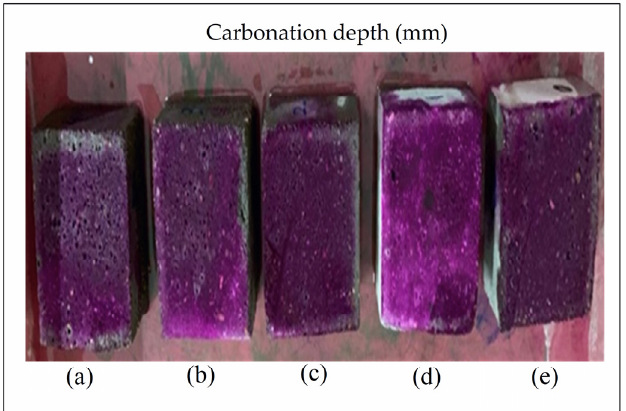
Figure 14. Carbonation depth of CM-UFS-GO composites. ( a )—CM1; ( b )—CM2; ( c )—CM3; ( d )—CM4 and ( e )—CM5.